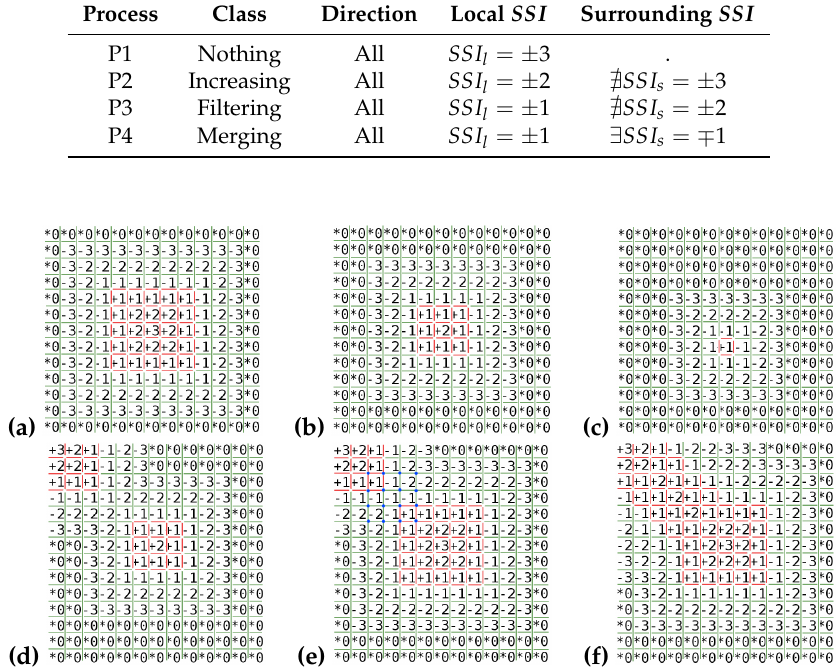
Figure A1. ( a – c ): Situations depending on the Surface State Index ( SSI ) inducing processes on the horizontal obstacle size: ( a ) Nothing ( SSI = 3); ( b ) Increasing ( SSI = 2); ( c ) Filtering ( SSI = 1). ( d – f ): Process combinations on the horizontal obstacle size function of SSI : ( d ) Reference state is two bodies; ( e ) Increasing one; ( f ) Merging the two bodies. The red contours indicate the presence of the obstacle. The green contours indicate the non-presence of the obstaclee. The blue points indicate the region to be